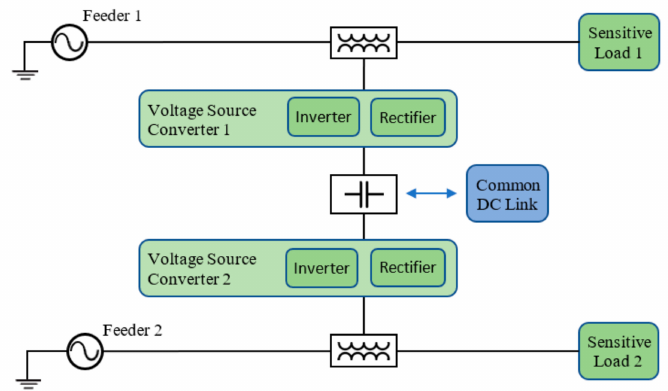
Figure 1. Schematic diagram of the interline dynamic voltage restorers (IDVRs) proposed in the literature. Where DC is Direct